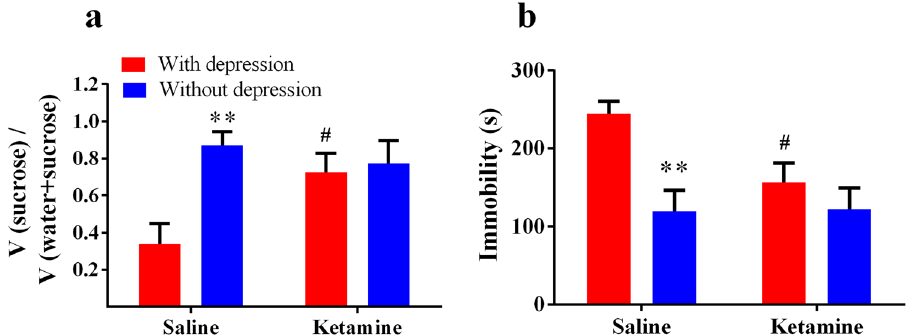
Figure 4. Ketamine’s antidepressant effects on day 14 after SNI surgery. ( a ) In the SPT, rats with depression- like phenotype displayed decreased sucrose preference than rats without depression-like phenotype rats after saline injection. A single injection of ketamine (20 mg/kg) attenuated decreased sucrose preference in the rats with depression-like phenotype. ( b ) In the FST, rats with depression-like phenotype displayed longer immobility time than rats without depression-like phenotype after saline injection. A single injection of ketamine (20 mg/kg) attenuated increased immobility time in the rats with depression-like phenotype. ** P < 0.01 for rats without depression-like phenotype vs rats with depression-like phenotype after saline treatment. # P < 0.01 for ketamine treatment vs saline treatment in rats with depression-like phenotype.